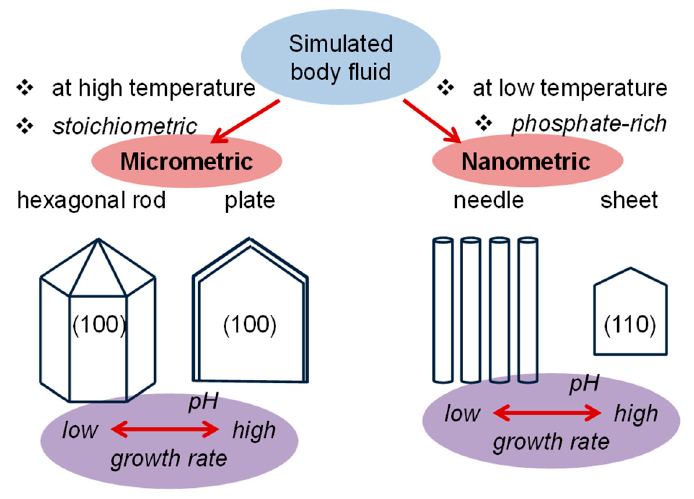
Figure 3. Change in the morphology of hydroxyapatite (HAp) crystals in simulated body fluid (BF) solutions according to stoichiometry, temperature, and pH. Growth rate becomes clearly enhanced by the increase of the pH of the medium. Indices indicate the crystal growth faces. Based on Reference [65].